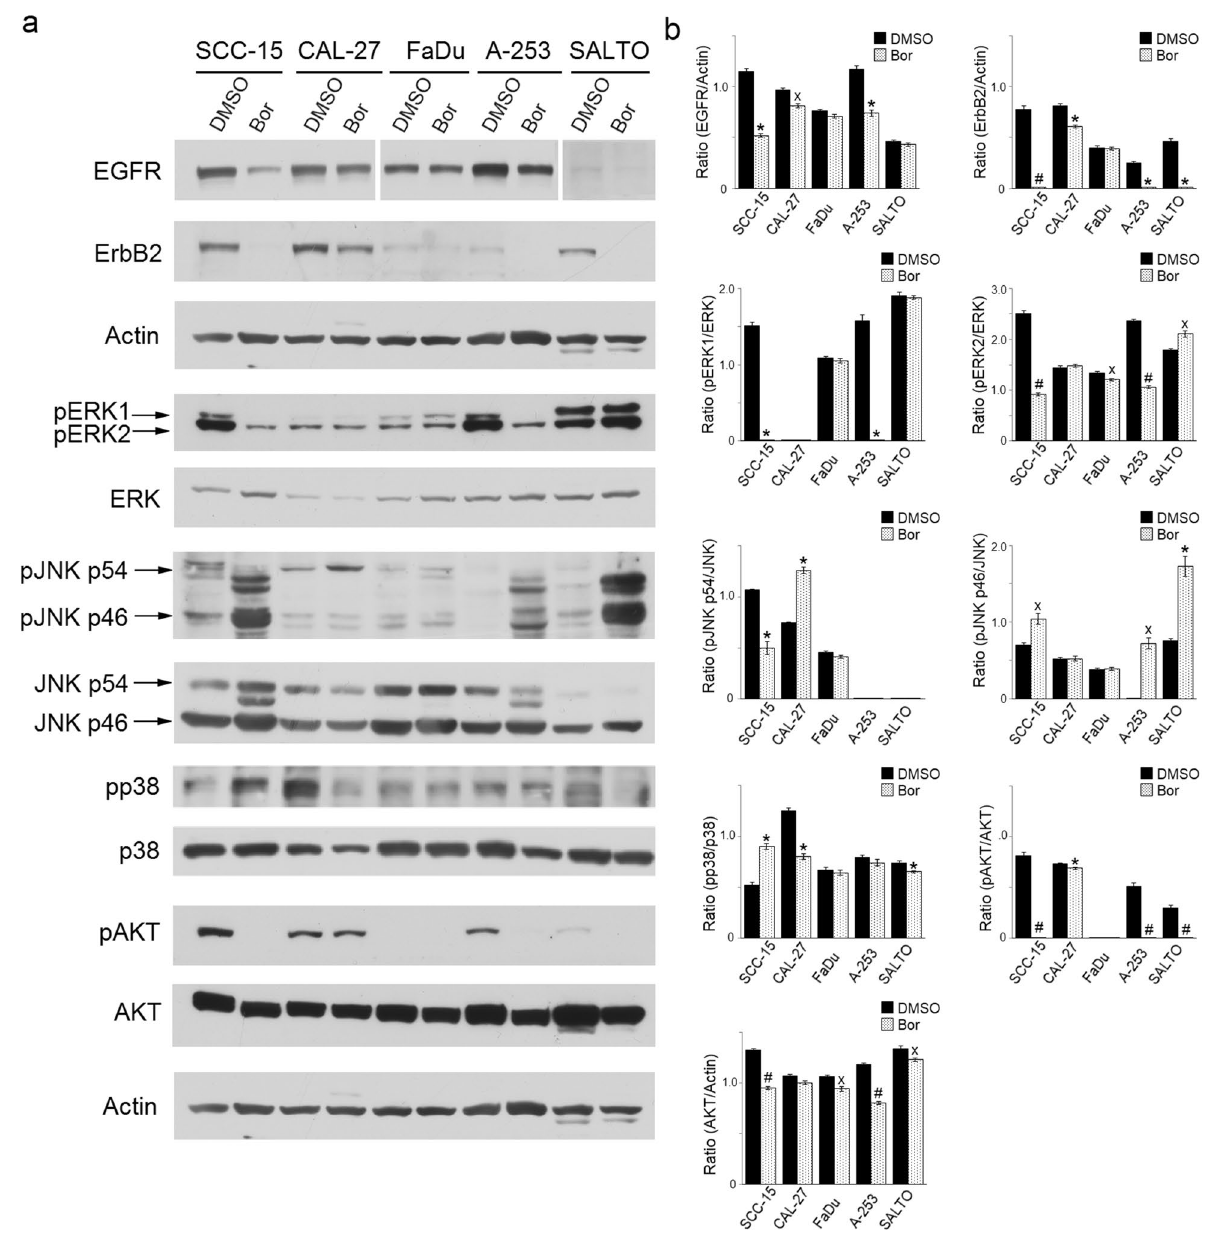
Figure 4. Effect of Bortezomib on the expression and activation of ErbB receptors (EGFR and ErbB2) and signaling transduction pathway molecules. ( a ) Western blotting analysis was performed on HNC cells treated with Bortezomib (Bor) or DMSO for 24 or 48 h, at a dose of 12.5 (SCC-15, CAL-27) or 25 nM, as reported in Materials and Methods. The levels of pERK1, pERK2, pp38, pJNK, as well as pAKT, were compared with that of total ERK, p38, JNK, and AKT proteins, respectively. The intensity of the bands was quantified using the ImageJ 1.53e software after blot scanning of two independent experiments. Actin was used as an internal control. ( b ) The densitometric ratios and statistical analysis are reported ( ˟ p ≤ 0.05, * p ≤ 0.01, # p ≤ 0.001 vs DMSO). Data are expressed as the mean ± SD of two independent experiments. Uncropped western blots are reported in Supplementary